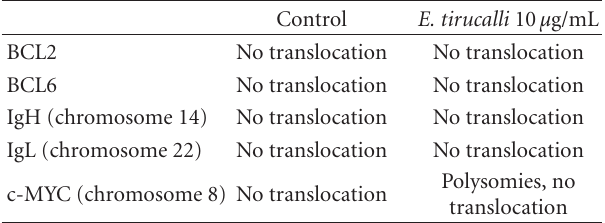
Table 3: FISH analysis on E. tirucalli treated versus untreated cells.